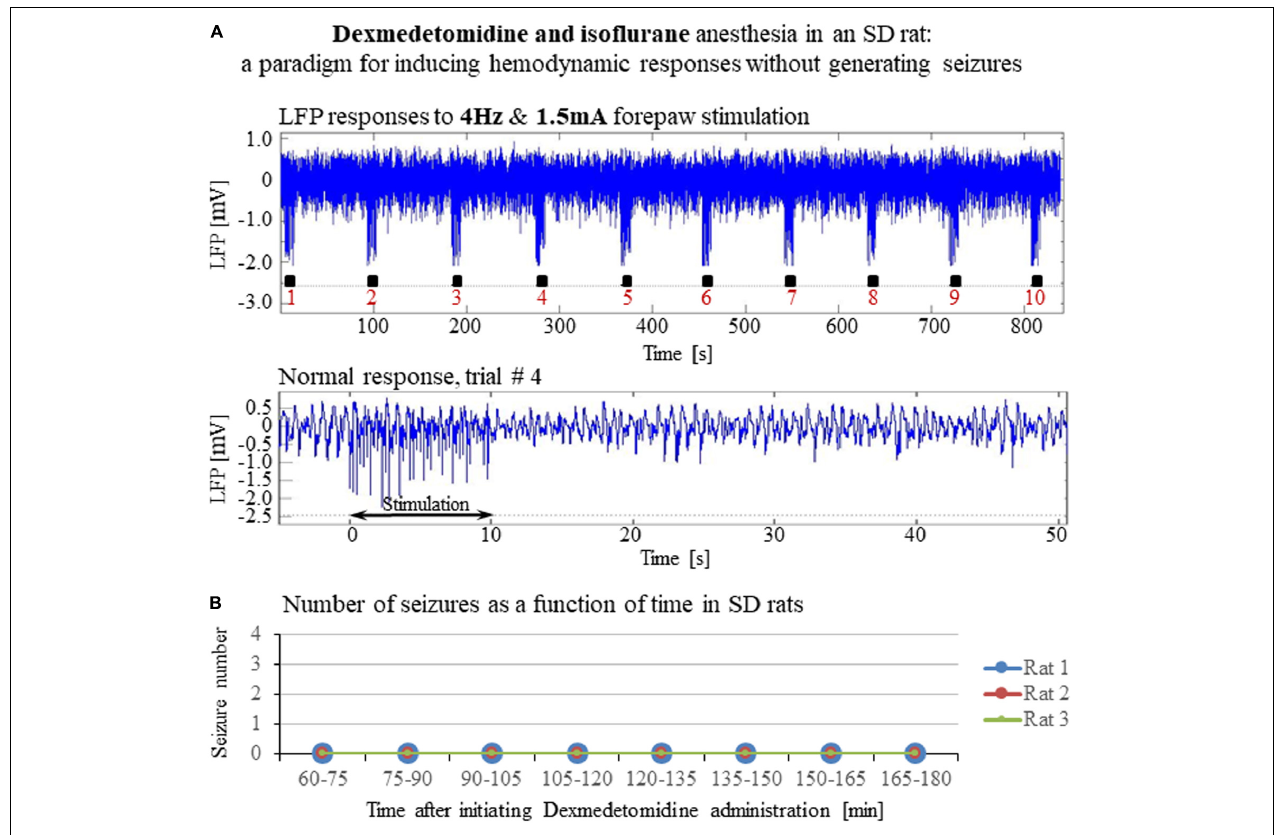
FIGURE 8 | A paradigm for seizure-free forepaw stimulation under dexmedetomidine and isoflurane. The data presented in this figure were obtained from 3 rats under dexmedetomidine and isoflurane anesthesia. Forepaw stimuli of 1.5 mA were administered at a rate of 4 Hz. (A) Top: Normal LFP responses to 10 s-long stimulation blocks obtained from area S1FL. Bottom: A magnification of the normal evoked response from the fourth trial. (B) The number of seizures (none) recorded in each of the 3 rats as a function of time shows that forepaw stimuli of 1.5 mA administered at 4 Hz do not induce seizures in SD rats under dexmedetomidine and isoflurane